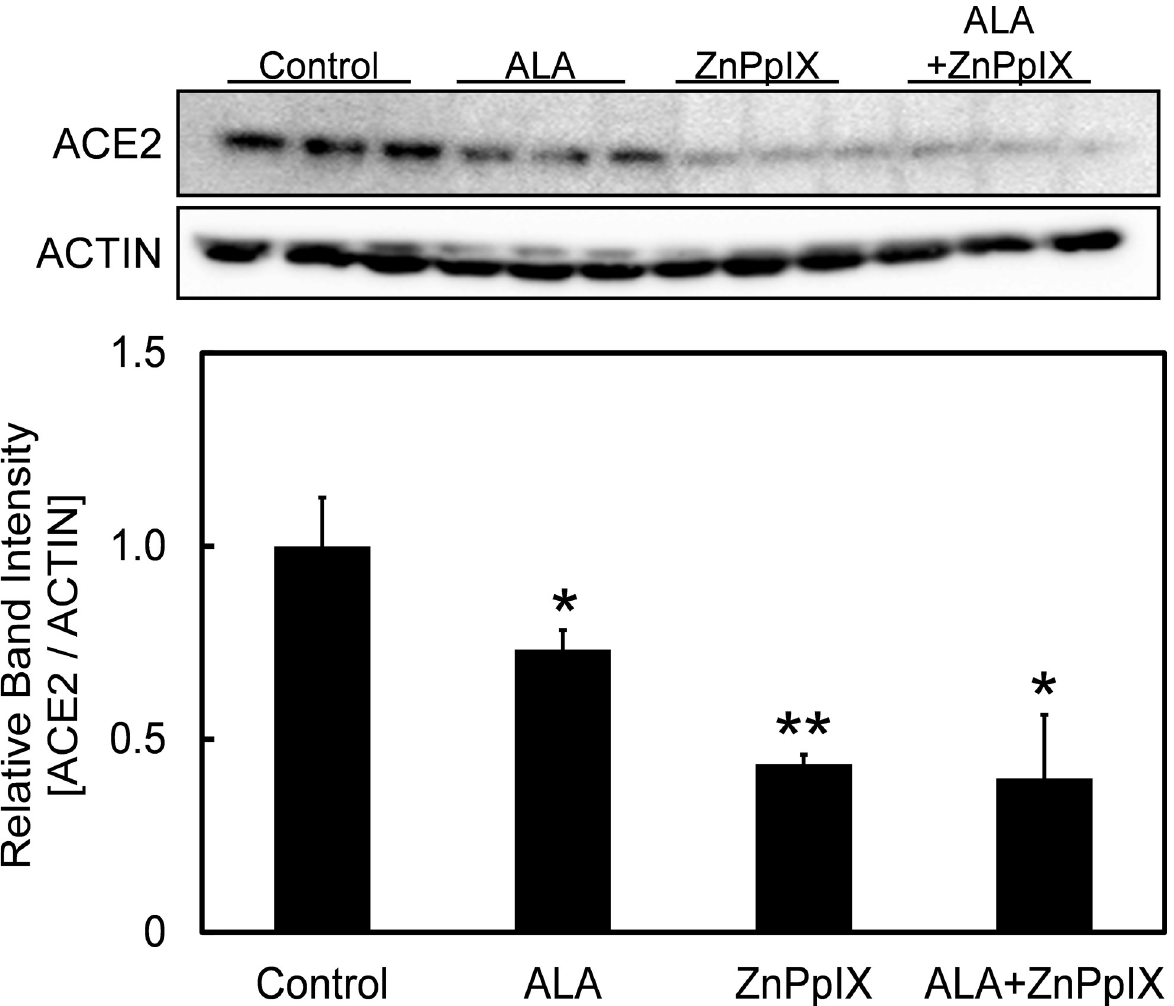
Fig 6. Changes of ACE2 expression following ALA administration and HO-1 inhibition in HepG2 cells. Changes in protein expression levels of ACE2 in HepG2 following administration of ALA and ZnPpIX, a HO-1 inhibitor. A one-way ANOVA (Tukey’s test) was performed for each data set to identify differences in mean values between treated and untreated samples; �� , p < 0.01; � , p < 0.05. n = 3. Bars represent standard deviation (SD). Blots are cropped to ease visualization. Unprocessed original blot scans are shown in S3